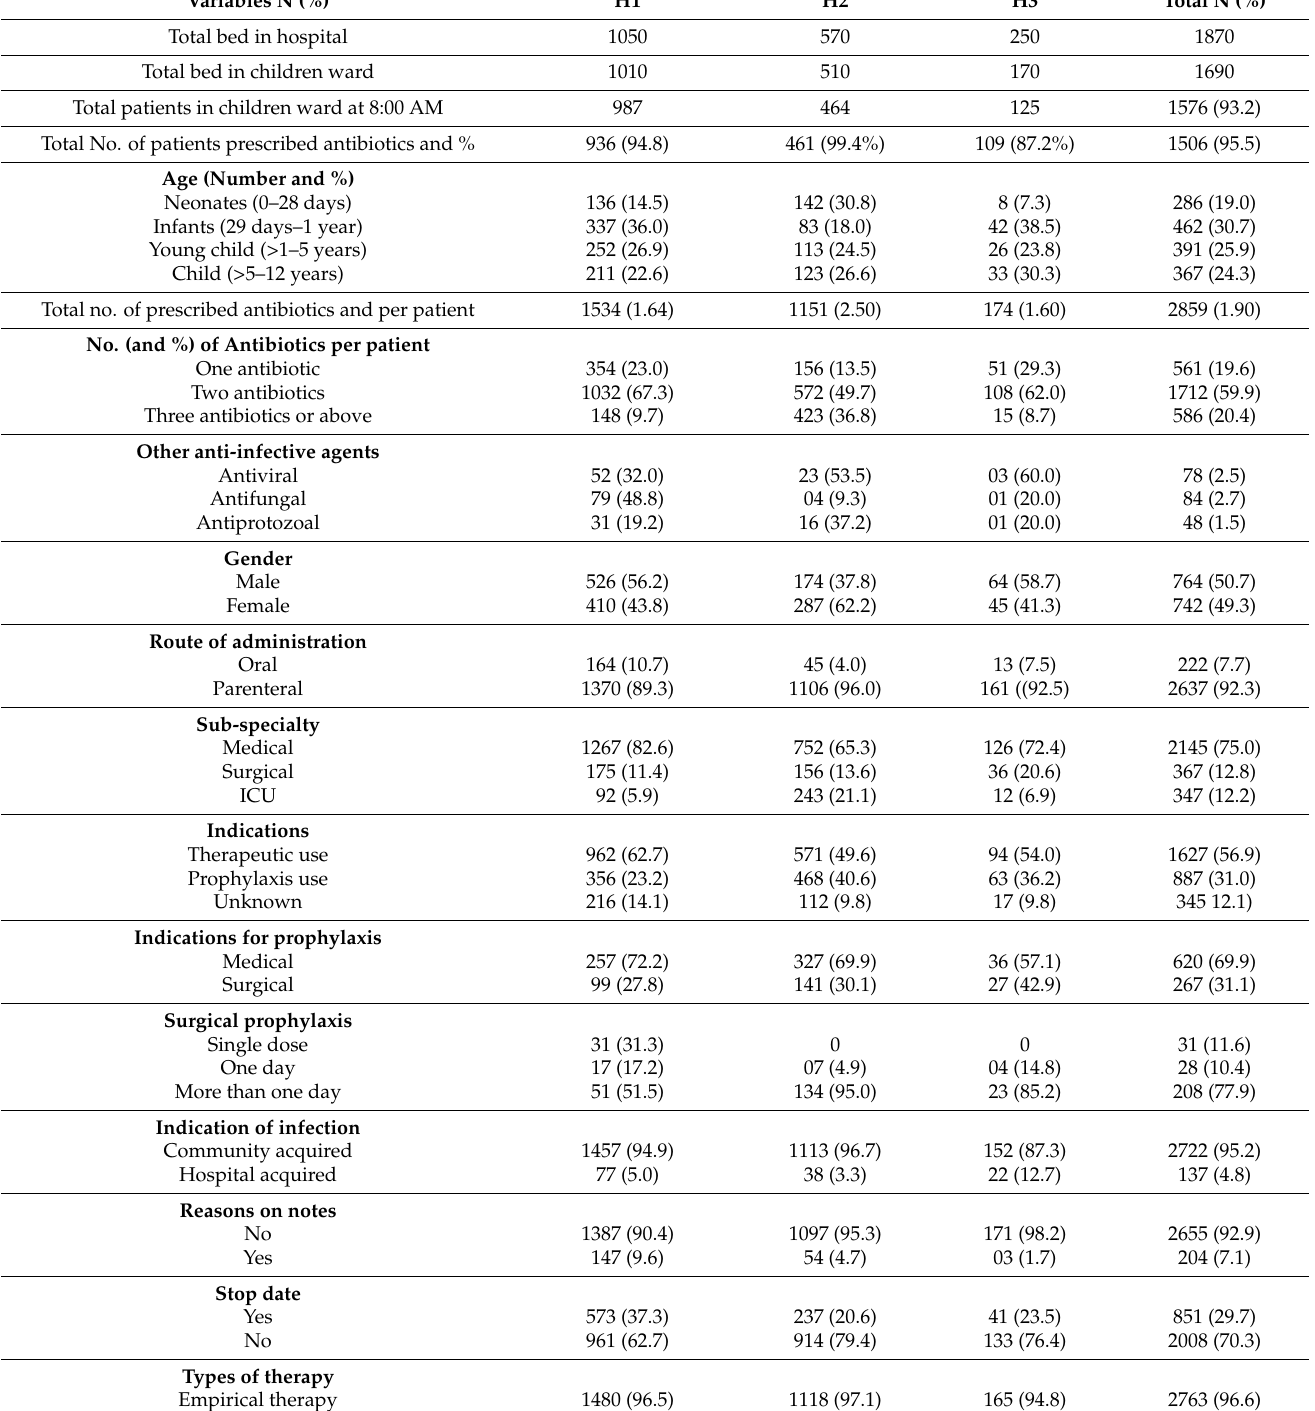
Table 1. Hospital, ward, patient, and antibiotics prevalence related